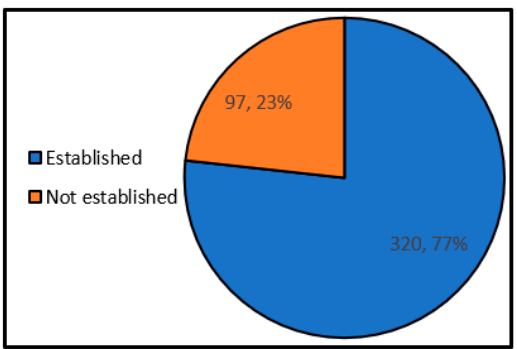
Figure 13. Information sharing system rules with disaster response headquarters (single answer) (Single answer, total number of answers 417, total number of local governments: 417, unit: group).